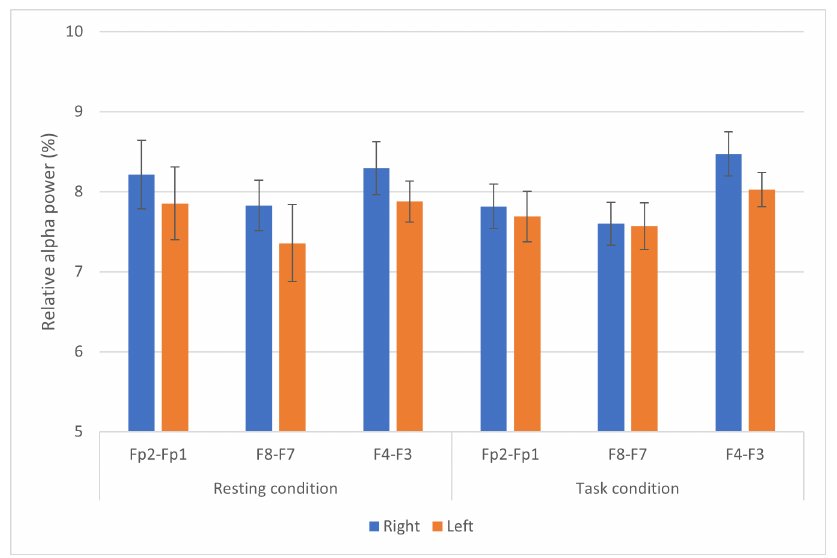
Figure 3. Relative alpha power (%) between the respective right (Fp2, F8, F4) and left (Fp1, F7, F3) brain areas. No differences were observed at all three electrode pairs during both conditions.